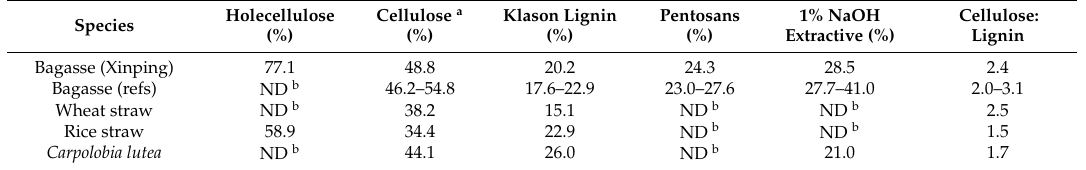
Table 1. Chemical composition of de-pithed bagasse [4,16] and other non-wood materials [7,14,15]. Species Holecellulose (%) Cellulose Bagasse (Xinping) 77.1 48.8 20.2 24.3 28.5 2.4 Bagasse (refs) ND b 46.2–54.8 17.6–22.9 23.0–27.6 27.7–41.0